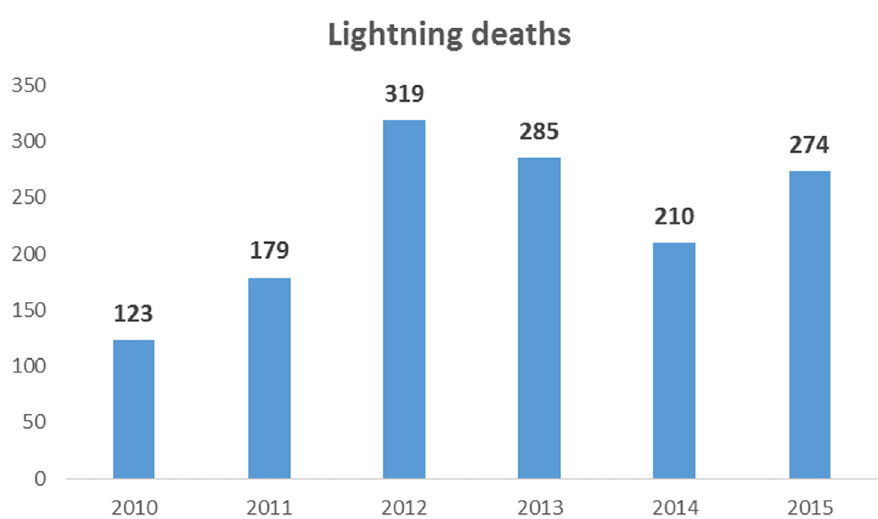
Figure 2. Magnitude of lightning injury from 2010 to 2015, according to the Foundation for Disaster Forum.